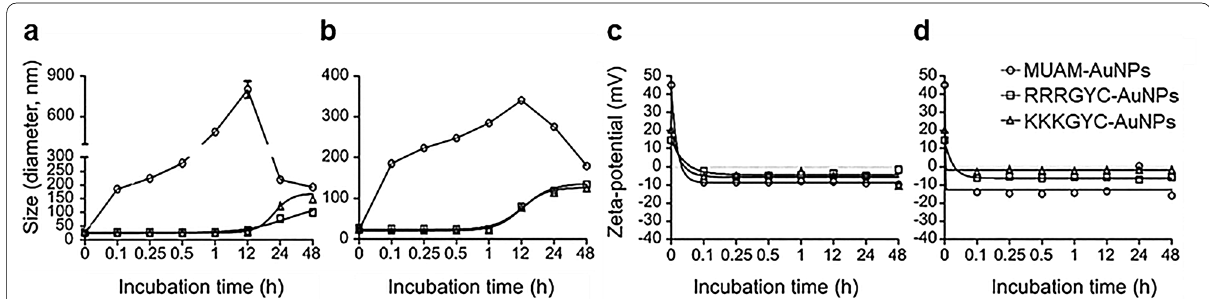
Fig. 5 Time-dependent study on the protein corona formation of cationic AuNPs in biological media. The sizes of AuNPs were measured using DLS in DMEM containing 1% FBS (D1) ( a ) and DMEM containing 10% FBS (D10) ( b ). The surface charge of cationic AuNPs was measured in D1 ( c ) and D10 ( d )